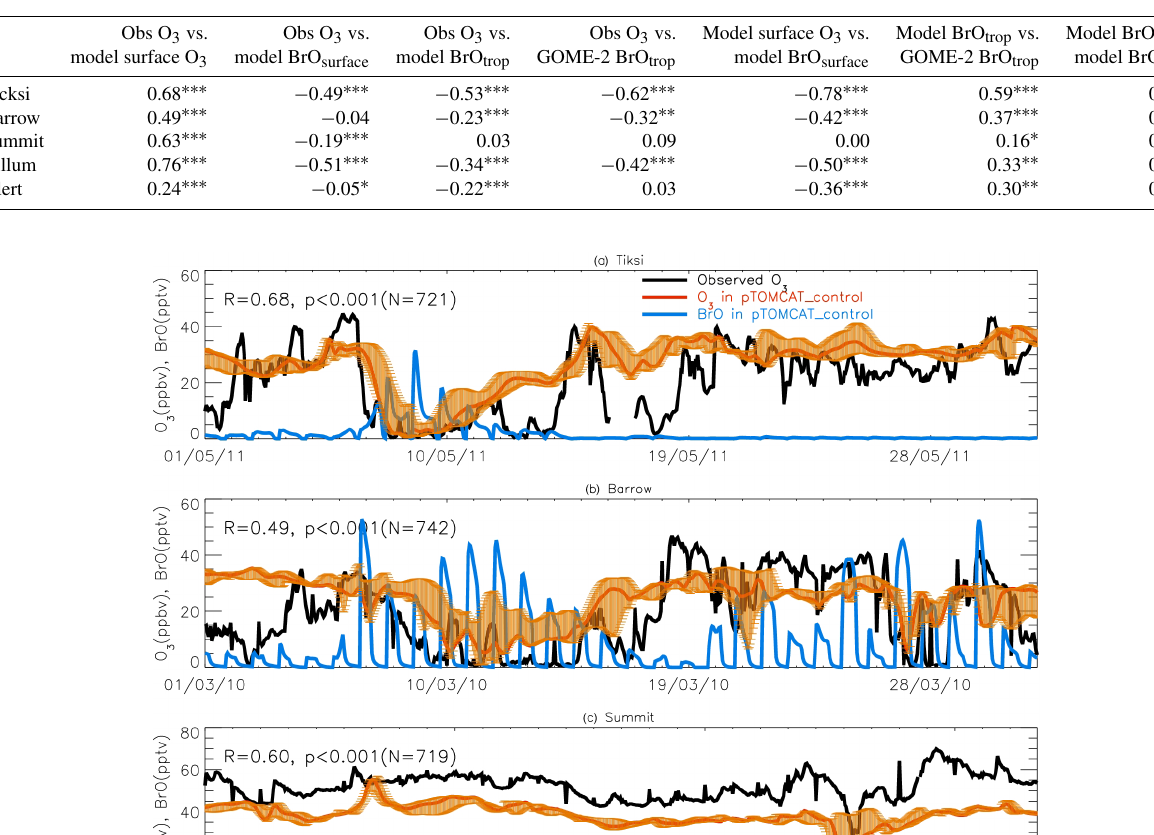
Table 4. Correlation coefficients ( R) at each site between various variables used in Figs. 6 and 7. Note that ∗ indicates probability value < 0.1, ∗∗ < 0.01, and ∗∗∗ < 0.001. BrO trop is tropospheric-column BrO, and BrO surface is surface BrO.